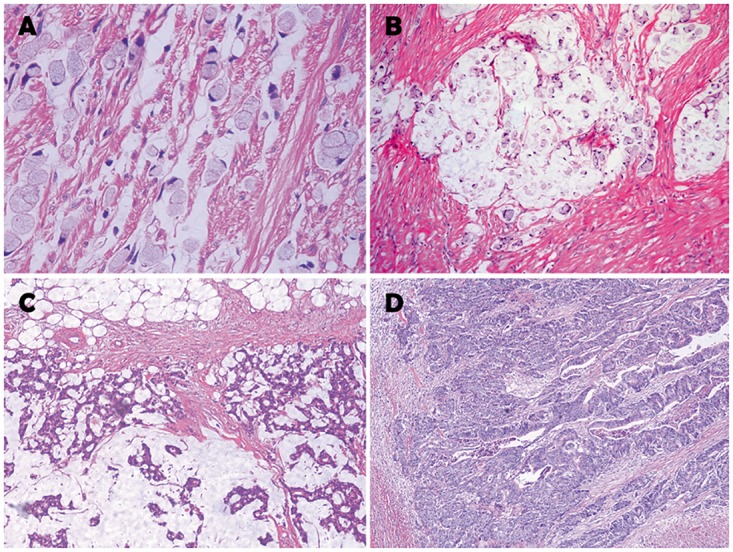
Representative histopathological images of different kinds of adenocarcinomas.(A) Signet-ring cell carcinoma. (B) Signet-ring cells floating in the pools of mucus are demonstrated. Mucinous carcinomas or classic adenocarcinomas with a minor signet-ring cell component were classified as partial signet-ring cell carcinoma. (C) Mucinous adenocarcinomas containing no signet-ring cells were classified as MAC or PMAC based on the proportion of mucin in the tumor. (D) Classic adenocarcinoma without any mucin or signet-ring cells.